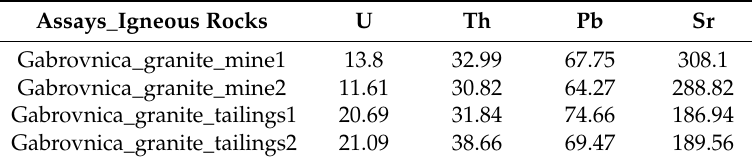
Table 4. Assays from Gabrovnica mine area (values are in ppm).